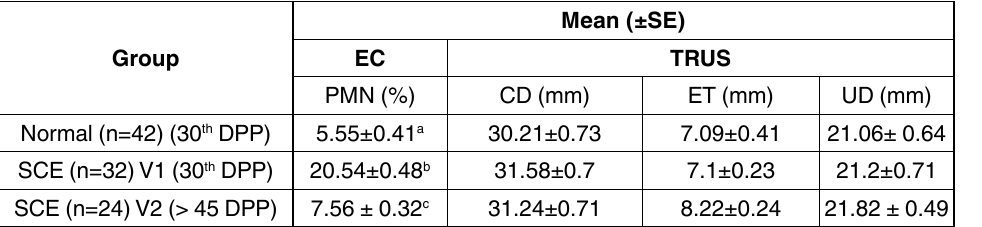
table 1 Endometrial cytology and TRUS findings in normal and SCE positive animals on different days of